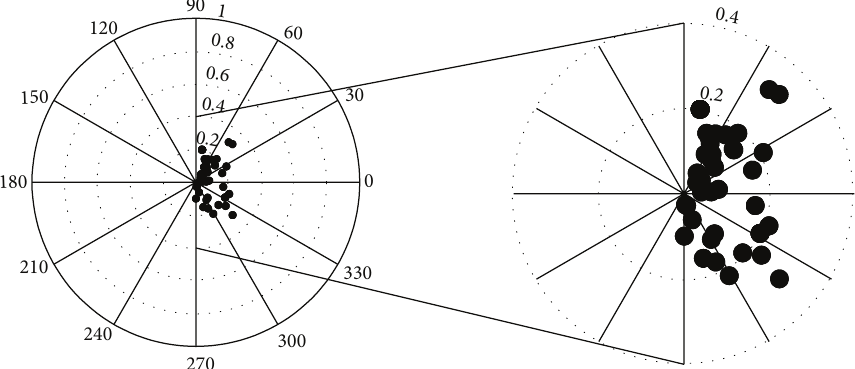
Grey: monthly occurrence of AMDR for individual stations Black: monthly average occurrence of AMDR